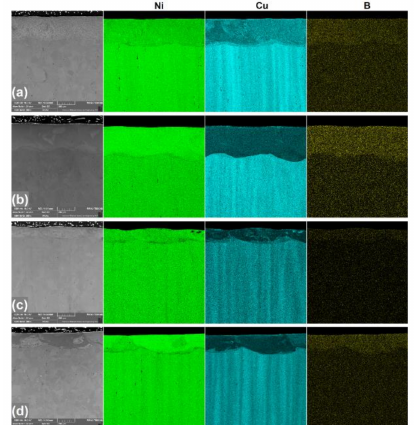
Figure 3. Laser borided layers produced on Monel 400 with di ff erent parameters with their EDS mappings: ( a ) v l = 5 m / min and t b = 100 µ m, ( b ) v l = 5 m / min and t b = 200 µ m, ( c ) v l = 50 m / min and t b = 100 µ m, ( d ) v l = 50 m / min and t b = 200 µ